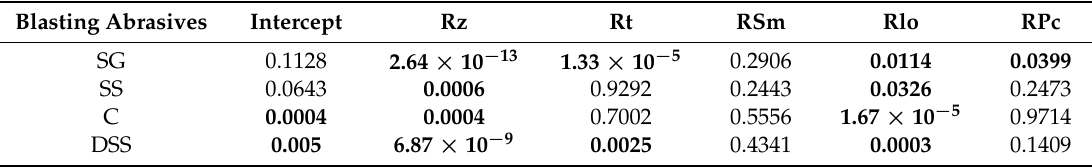
Table 9. Test locating constant and regression coefficients, p -value (Boltface—statistically significant variables).